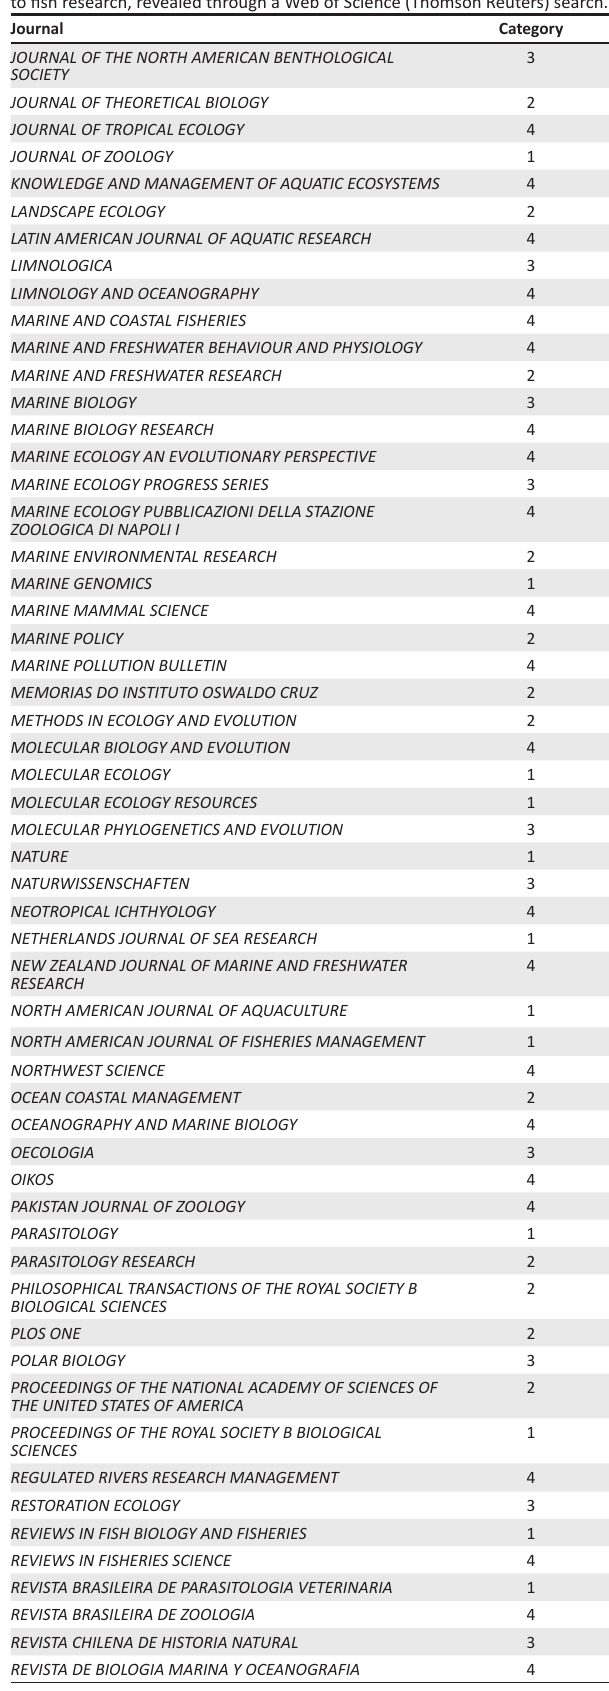
TABLE 1-A1 (Continues…): Categorisation, based on animal ethical requirements, of 250 ISI-rated, peer-reviewed, scientific journals with the most articles relating to fish research, revealed through a Web of Science (Thomson Reuters) search.